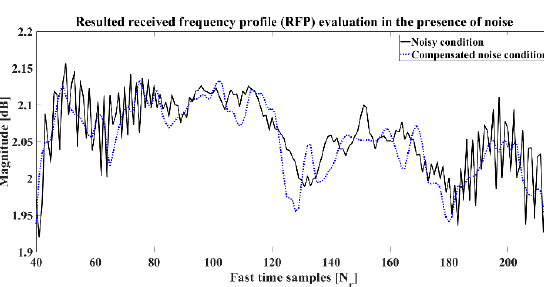
Figure 10. Resulting RFP presentation ( a – c ).